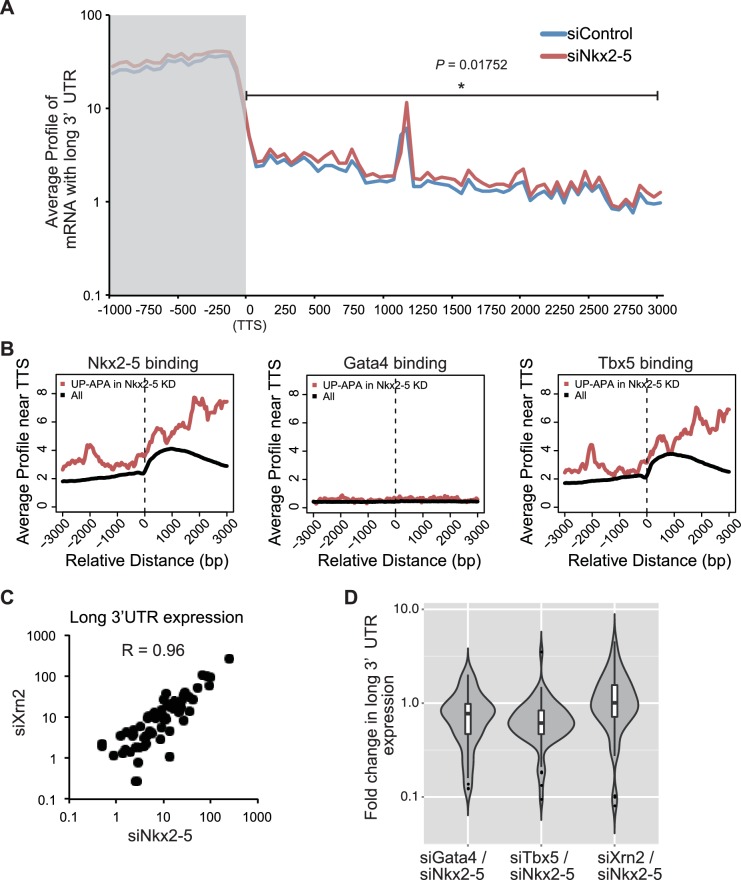
Correlation analysis of Nkx2-5 binding and long 3’UTR expression.(A) The average profiles of the mRNAs with long 3’ UTRs in genes that Nkx2-5 binds to TTS (3997 genes) in eCMs transfected with the indicated siRNAs. The gray area indicates the coding region. Significance was assessed using the two-sample Kolmogorov-Smirnov test. (B) The average profiles of Nkx2-5, Gata4, and Tbx5 binding in genes that their long 3’ UTRs were increased in Nkx2-5-knockdown eCMs. (C) Correlation plot of long 3’UTR expression between indicated knockdowns and Pearson correlation, related to Figure 4I. (D) Violin plots of fold change in long 3’UTR expression with box plots.